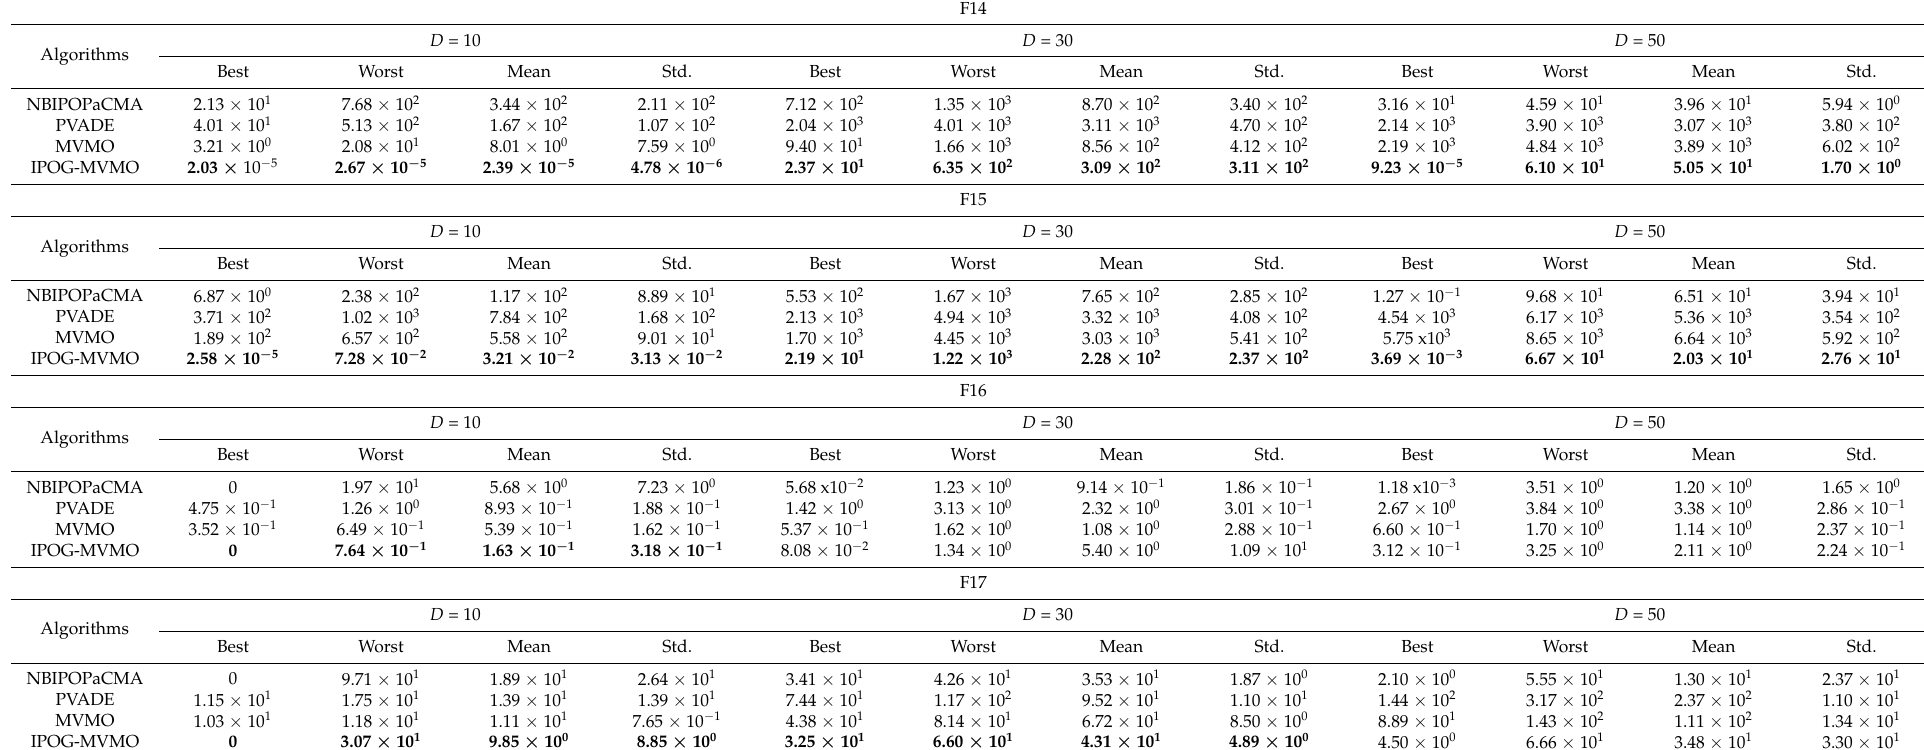
Table 5. The comparative results of the errors obtained from multimodal functions